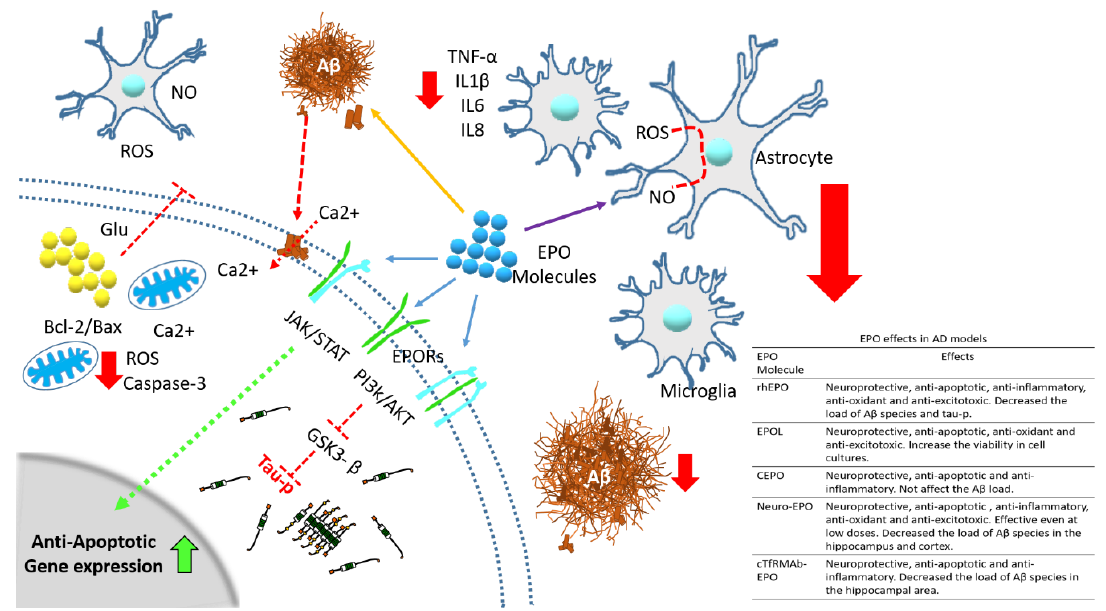
Figure 5. Protective effects of rhEPO and its molecular variants against the damages produced by the abnormal accumulation of proteins (Aβ and tau-p) analyzed in different models of AD. The rhEPO or its molecular variants through of the interaction with its receptor (different complex of them) (blue arrows) they activate molecular pathways (such as PI3K/AKT or JAK/STAT) responsible for decreasing the abnormal cellular processes such as apoptotic gene expression (dotted green arrow and solid green arrow into nucleus), caspase-3 activation (red arrow), release of Glu (dotted red line), over activation of GSK3- β (dotted red line) all them inside the cell and cytokines production (red arrow) outside of cell, among others, associated with cellular damages by apoptosis, oxidative stress and excitotoxicity. In addition, have been proposed that the exogenous EPO molecules also may avoid the aggregation of Aβ (yellow arrow) and tau-p through to join with them and decreasing their load in brains during AD progression. The pathological mechanism in this disease also involve the participation of glial cells, responsible to increase the level of free radical and pro-inflammatory cytokines and inducing neuronal cell death, although they are also regulated by the EPO/EPOR protective system (purple arrow). Red big arrows refer to decreased cellular alterations by EPO treatment.